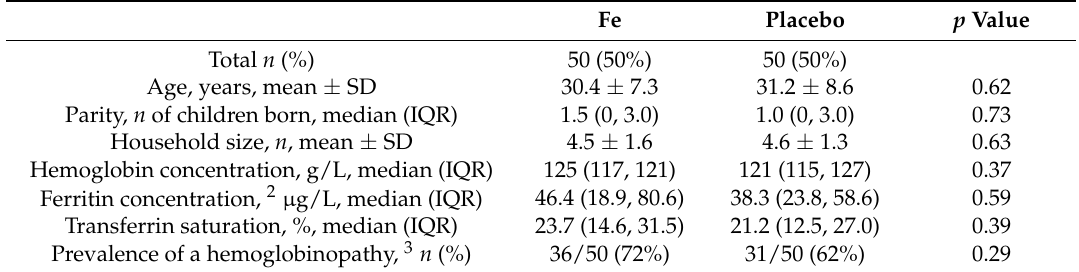
Table 1. Baseline characteristics of enrolled non-pregnant Cambodian women (18–45 years).